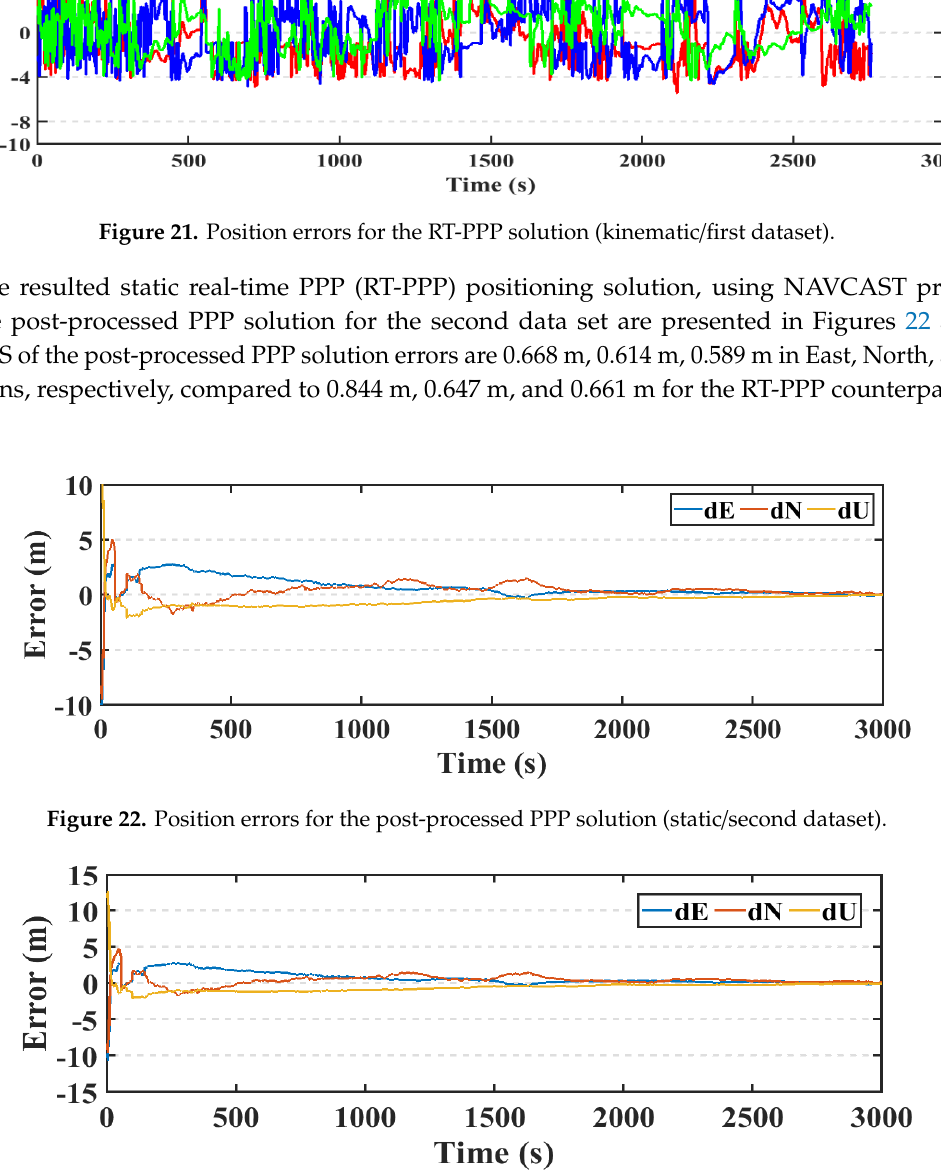
Figure 23. Position errors for the RT-PPP solution (static/second dataset).